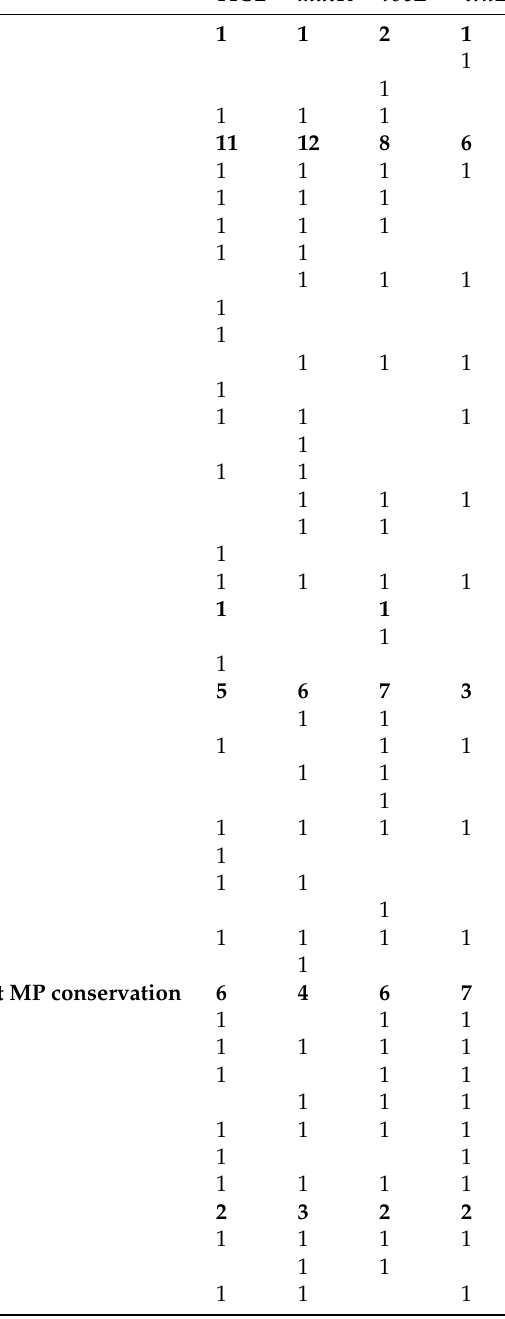
Table A1. DNA barcoding regions used for medicinal plant (MP) conservation in Indonesia. DNA Barcoding Use for MP Conservation in